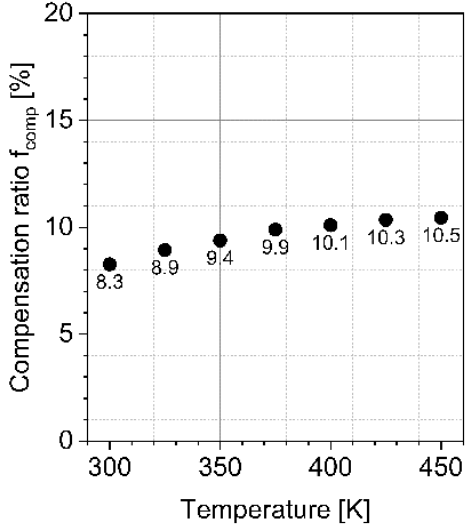
Figure 6. Temperature dependence of determined compensation ratio.